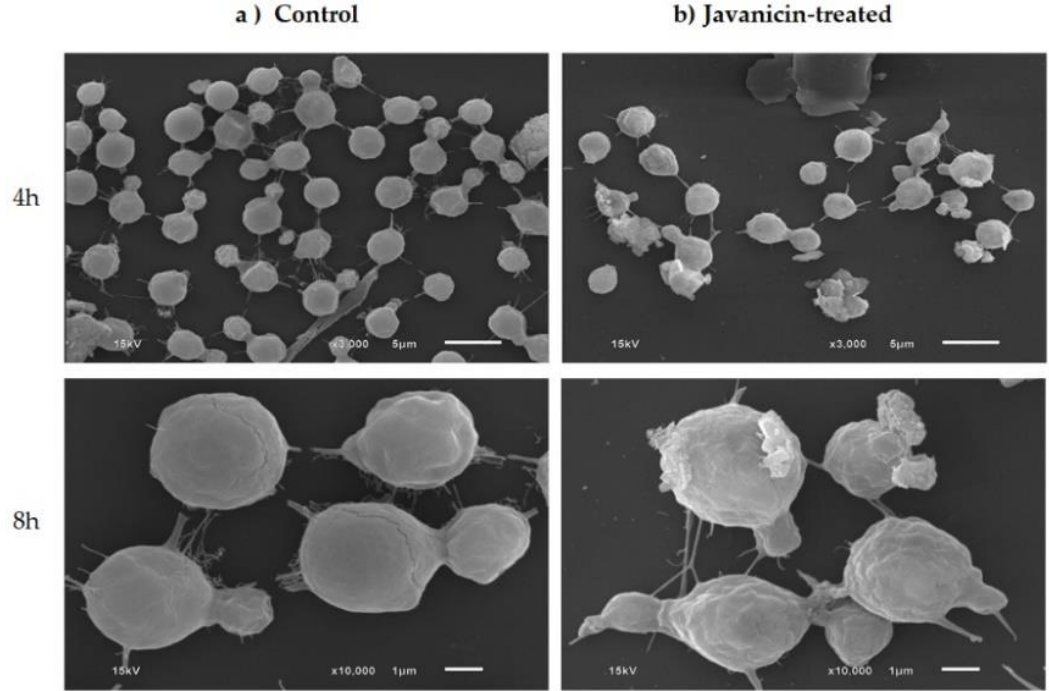
Figure 2. The illustration of SEM image segmentation of C. neoformans H99 strain in either untreated or r-javanicin treated. Panel ( a ) represented untreated cells control. Panel ( b ) indicated the yeast cells incubated with r-javanicin at its MIC value. Photographs were taken at 4 and 8 h after treatment. Bars at 4 and 8 h indicated 5 and 1 µ m, respectively. There is negligible difference with slight shrinkage was observed in r-javanicin treated groups when compared to the untreated